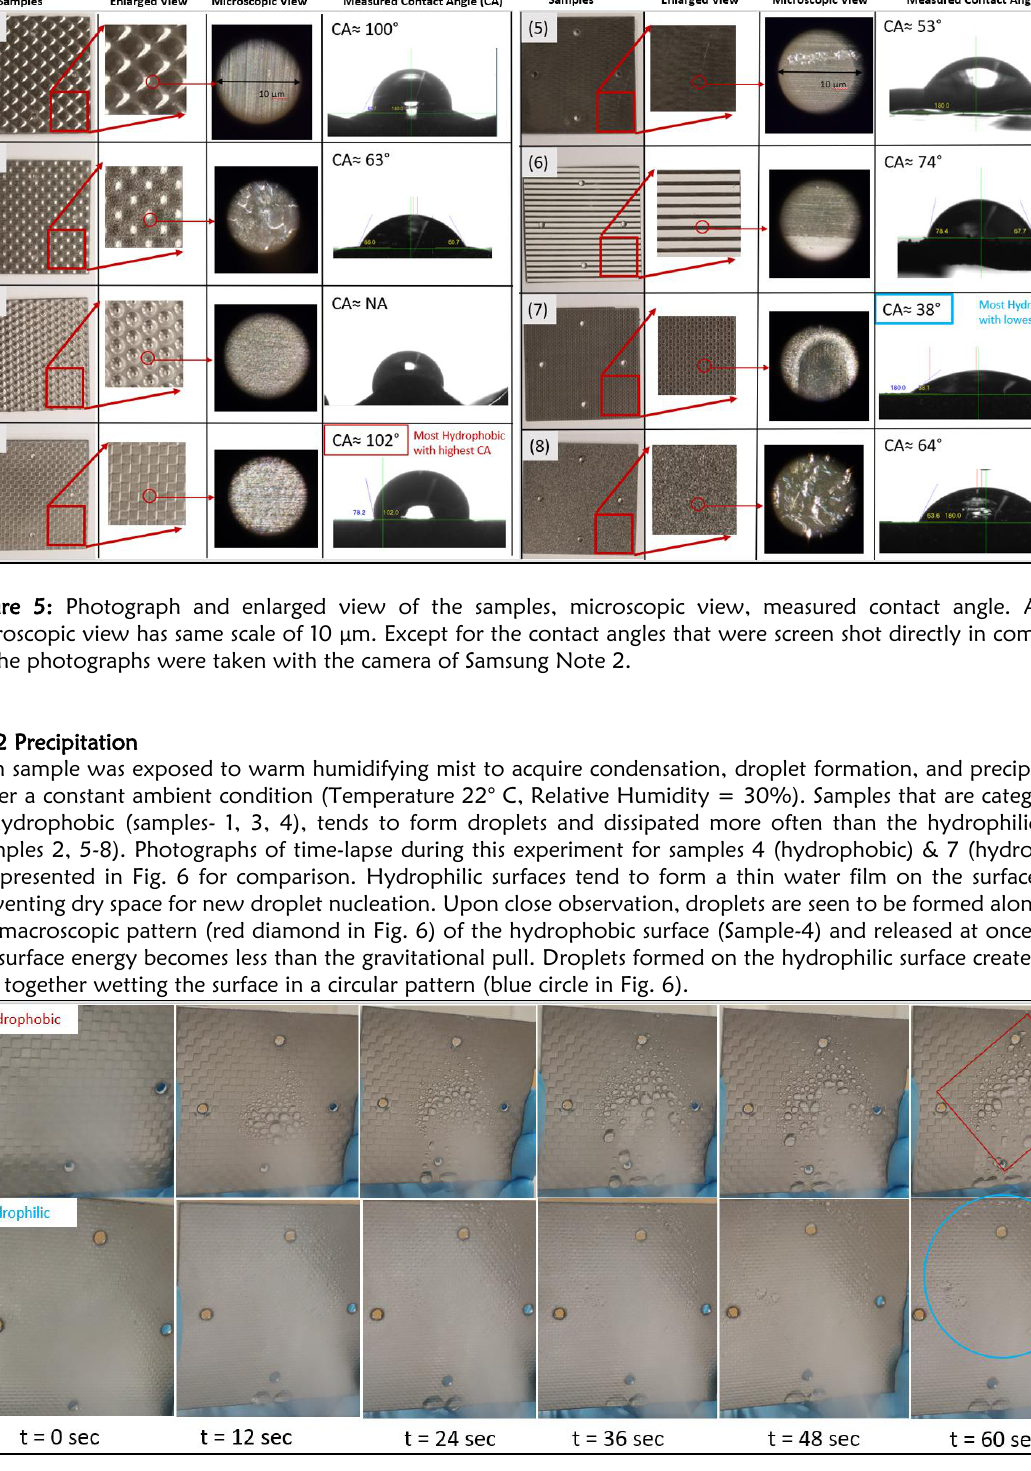
Figure 6: The comparison of time evolution on the droplet growth, movement, and sweeping process on Hydrophobic and hydrophilic SS surface with different macro patterns. All the photographs were taken with the camera of Samsung Note